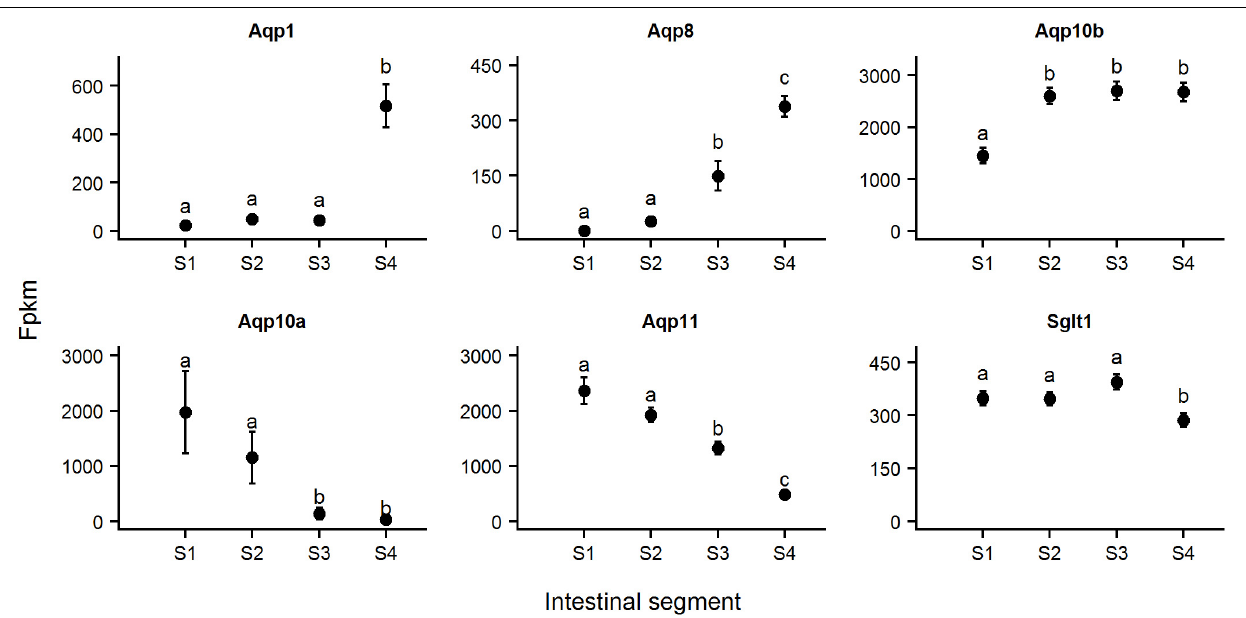
FIGURE 12 | Expression of Aquaporins (Aqp) and sodium–dependent glucose cotransporter 1 (Sglt1) genes. The graphs show the expression of these genes in tissues from four intestinal segments (S1–S4) of ballan wrasse. Fpkm, fragments per kilobase million. Different letters denote significant differences between intestinal segments ( p <